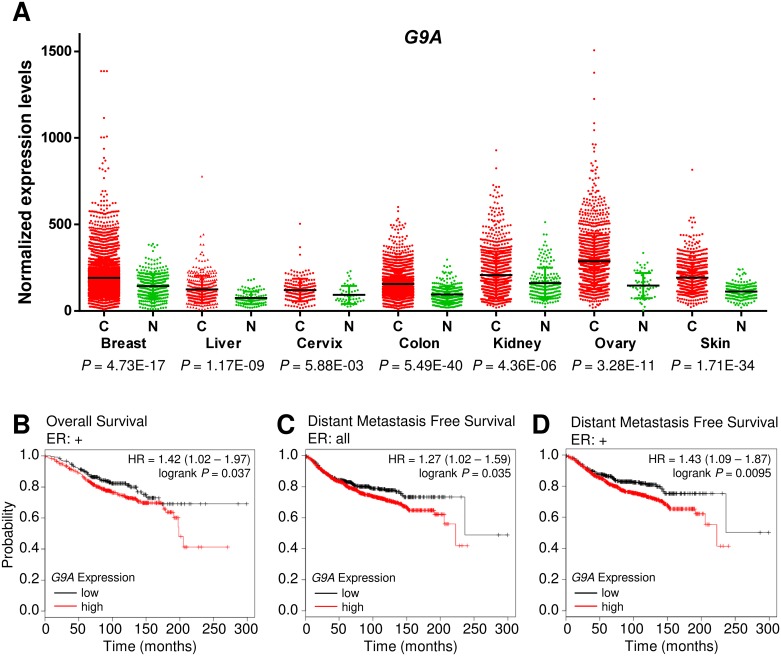
G9A is upregulated in diverse malignancies and is a predictor of poor survival in breast cancer.(A) Scatter plot showing increased G9A expression in cancers (C, red) compared to normal tissues (N, green) from the GENT database. Black lines indicate average gene expression levels. (B) Kaplan-Meier Plotter data showing the probability of overall survival in ER+ breast cancer patients and (C) distant metastasis free survival in all breast cancer patients and (D) ER+ breast cancer patients, with high G9A expression (red line) compared to low G9A expression (black line; HR, hazard ratio).